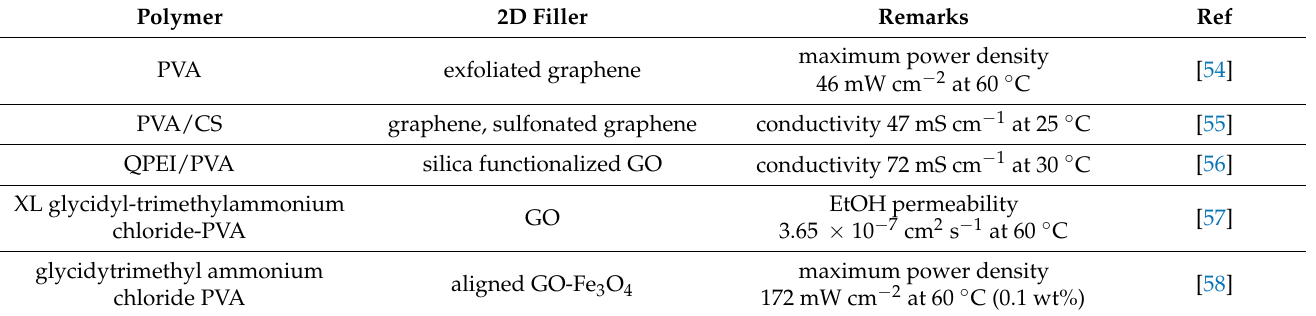
Table 3. Type of polymer and 2D filler in composite AEM with graphene, GO, carbon nitride or boron nitride.